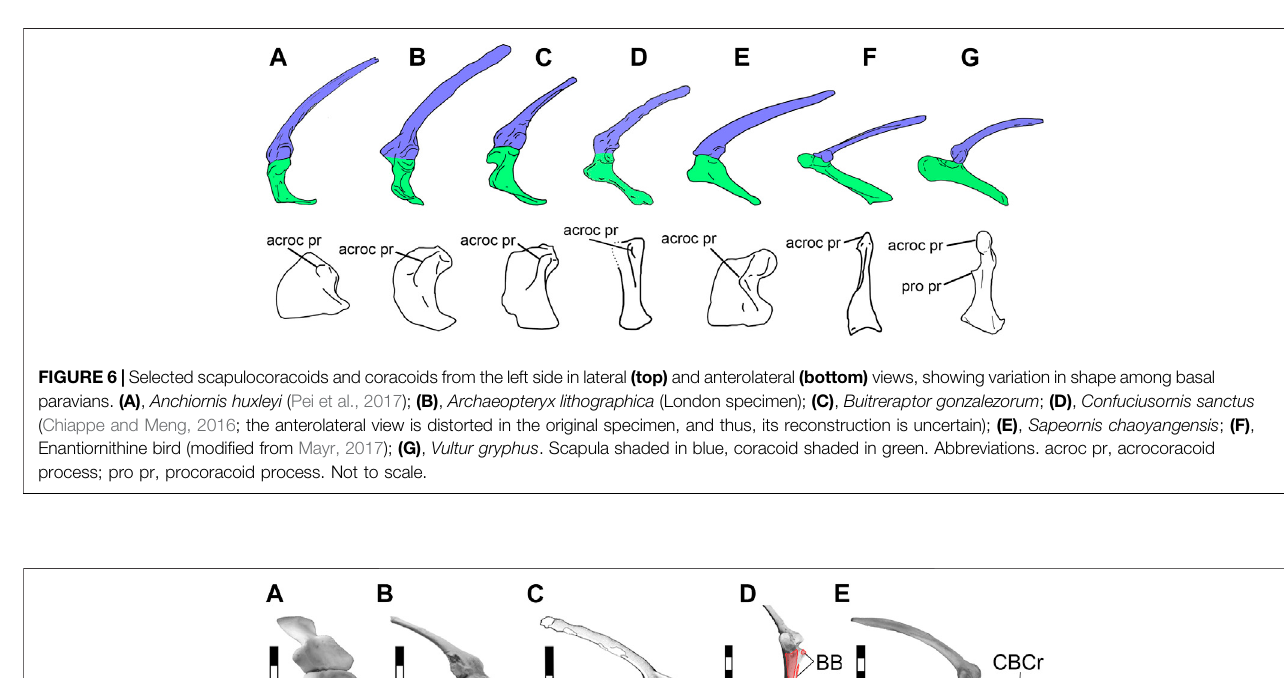
Frontiers in Earth Science |